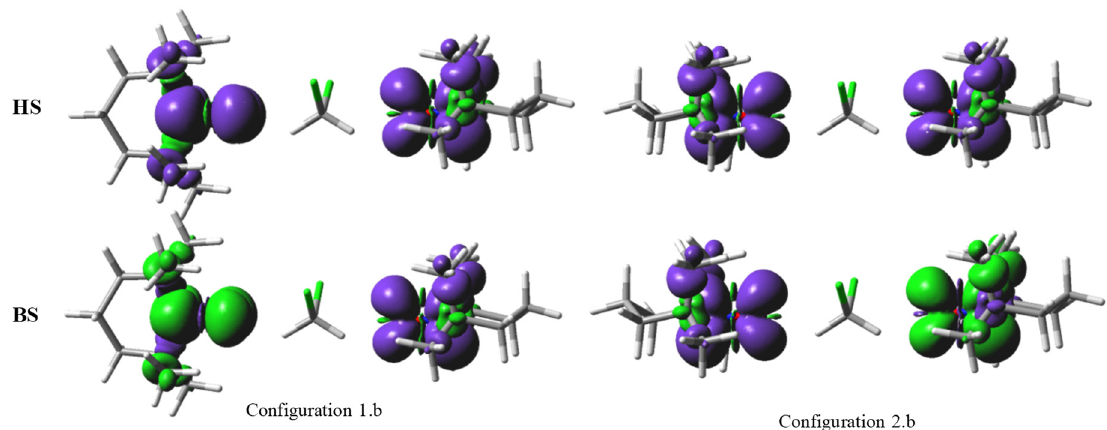
Figure 8. The spin density maps, as 0.001 e / Å 3 contours, for the 1.b and 2.b configurations, at the r = 6 Å separation between the oxygen atoms of the colinear NO groups, with the oxygen atoms in the vicinity of the hydrogen atoms of the dichloromethane molecule. The notations and colouring are similar to those from Figure 7.